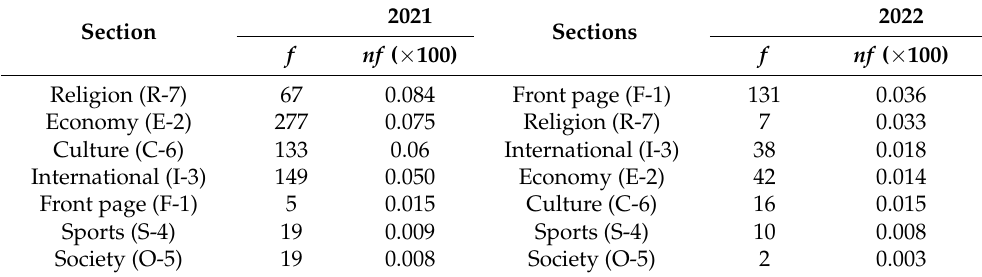
Table 7. Descending order of nf ( × 100) of multiple sections for the 2021 and 2022 samples.